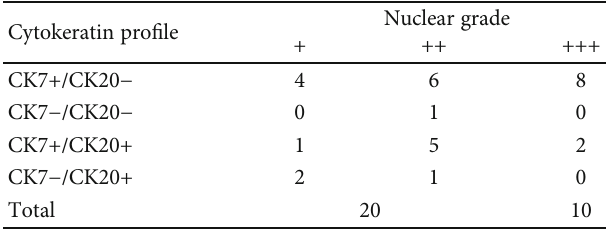
Table 4: Number of cases by nuclear grade and cytokeratin pro fi le.